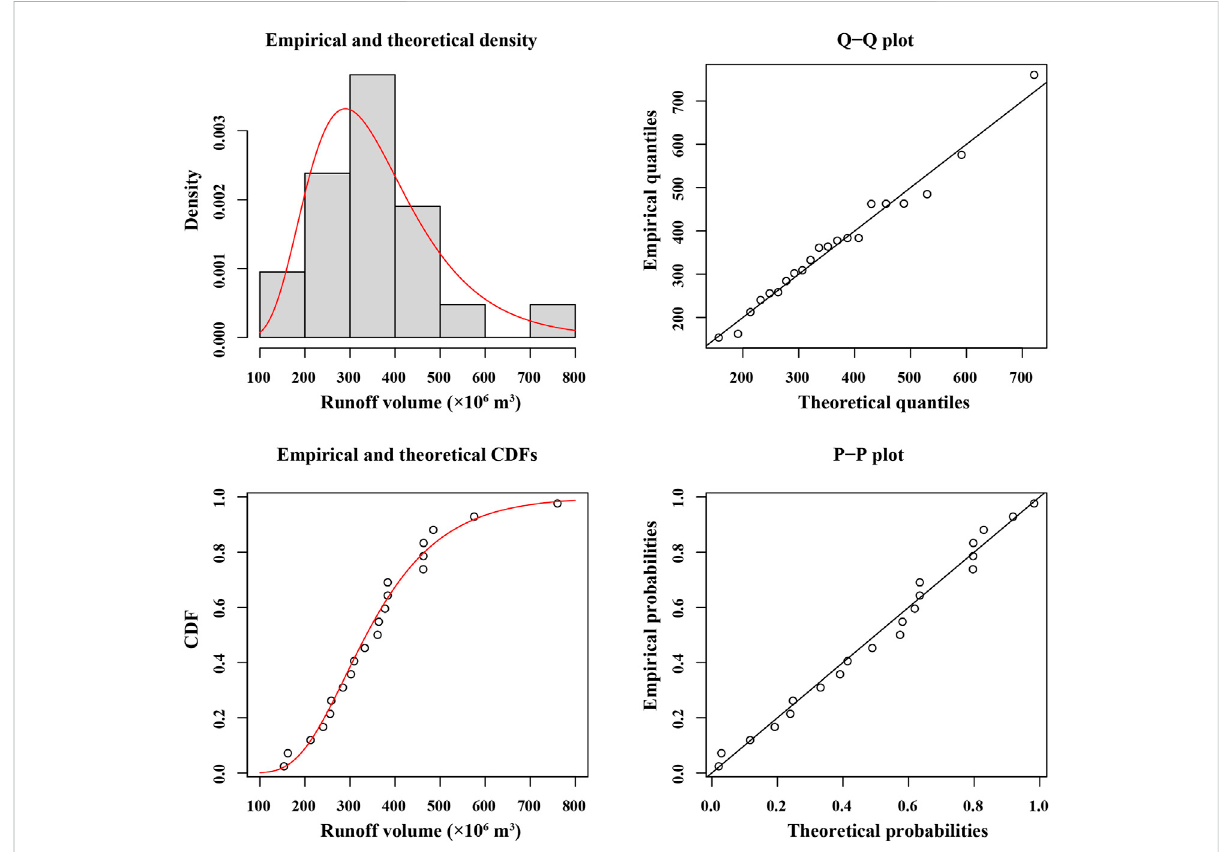
FIGURE 5 Fitting distribution results of source 3 with log-normal distribution.